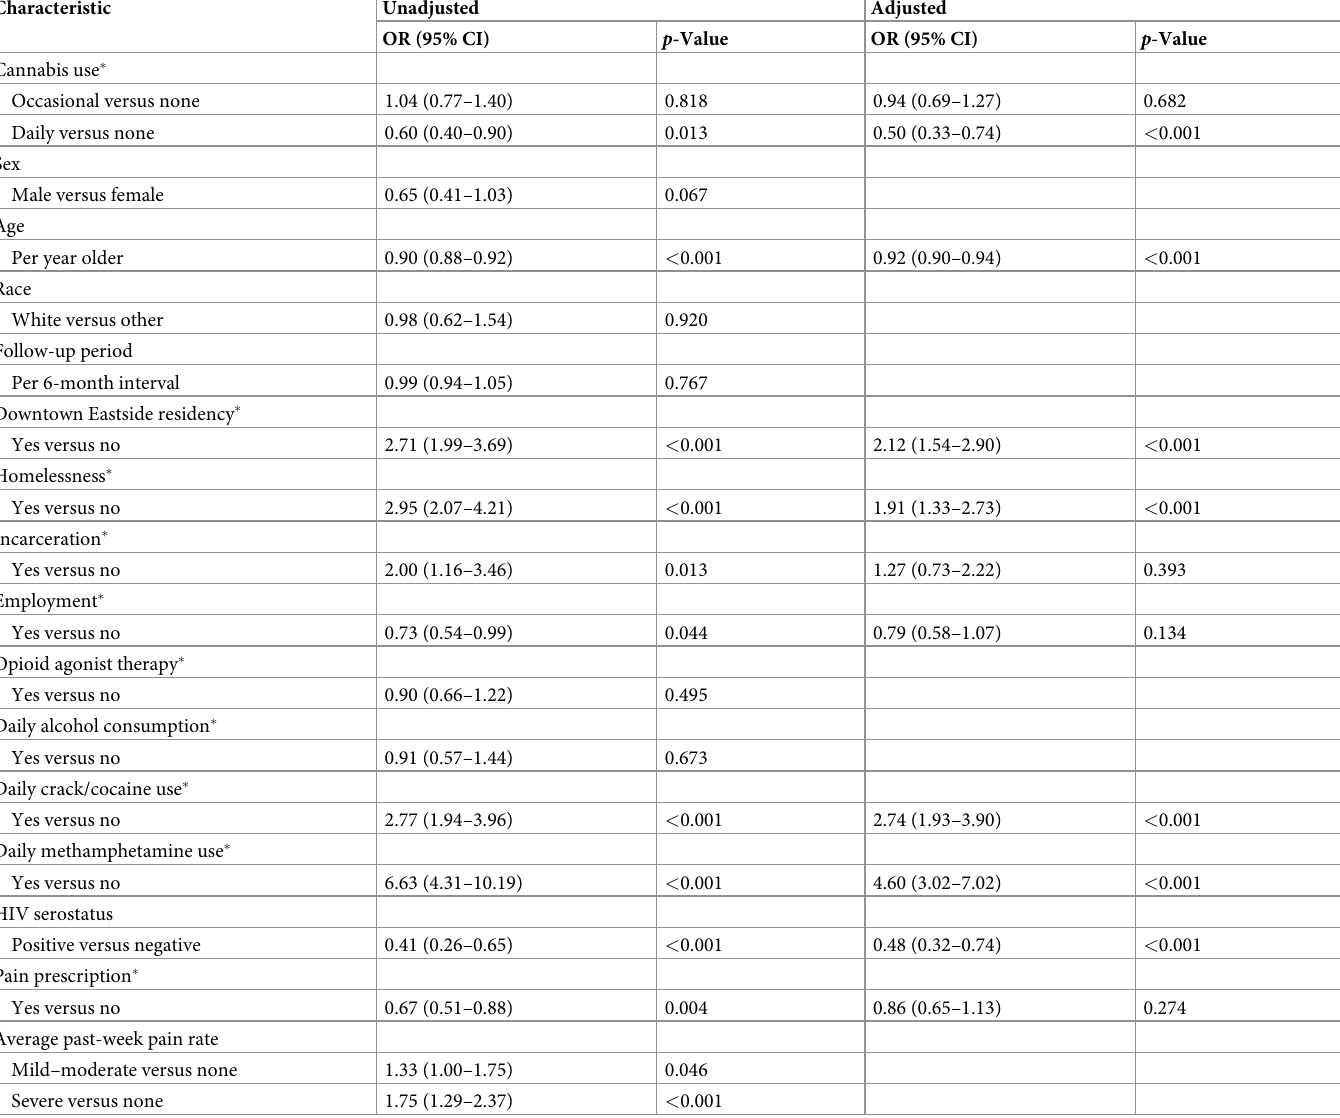
Table 2. Unadjusted and adjusted generalized linear mixed-effects models of factors associated with daily illicit opioid use among 1,152 people who use drugs with chronic pain in Vancouver, Canada.